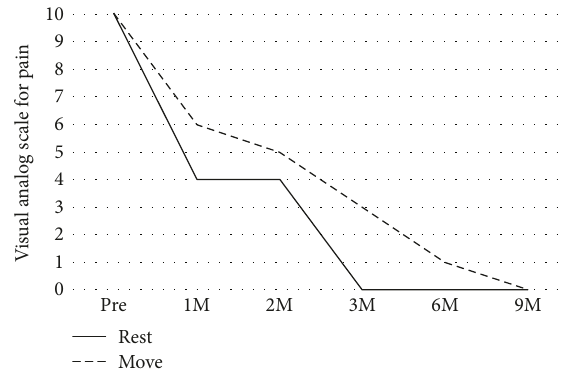
Figure 5: Postoperative course of visual analog scale (VAS) for Table 1: The amount of blood components.